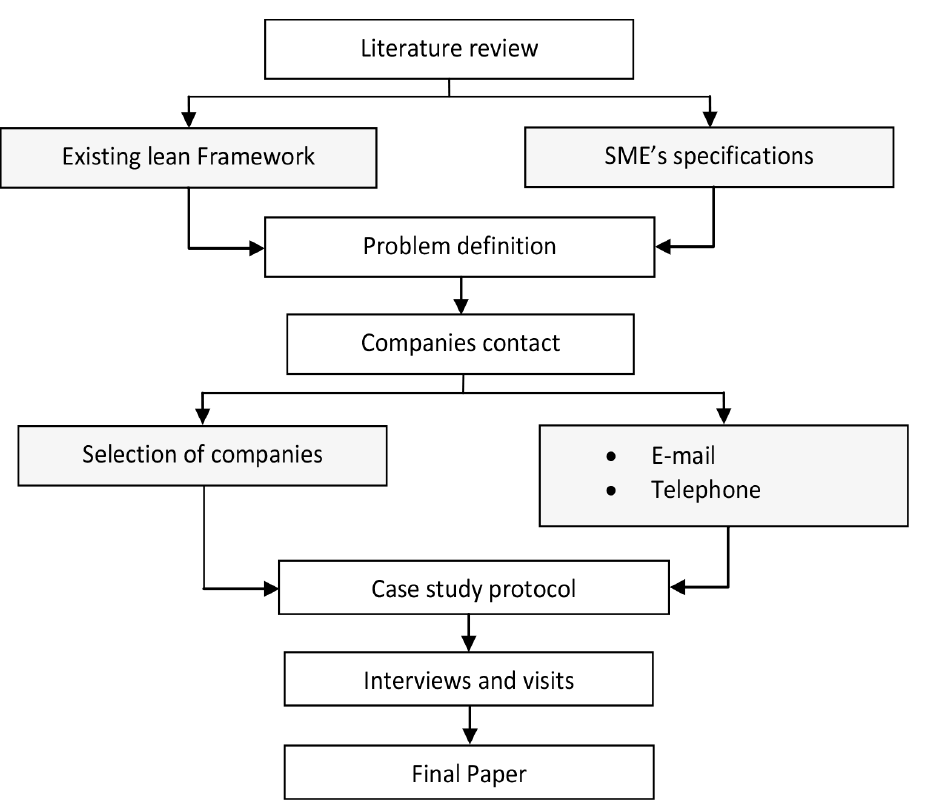
Figure 2. Research